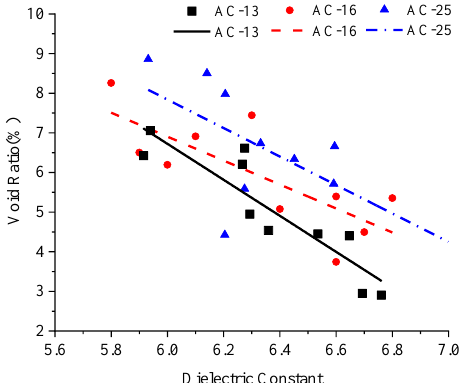
Figure 5. Distribution diagram of void fraction and dielectric constant of test piece.